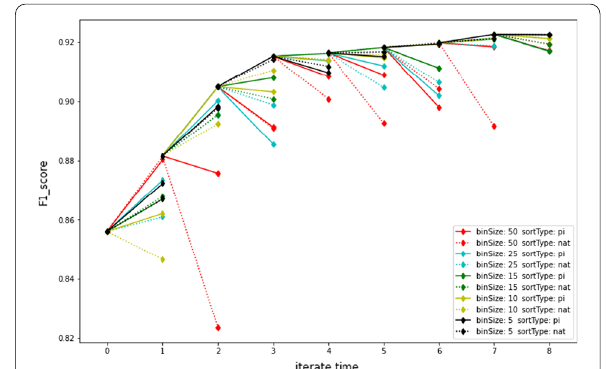
Fig. 6 Visualization of feature selection process based on PI and